Question: In one sentence, what is this figure communicating?
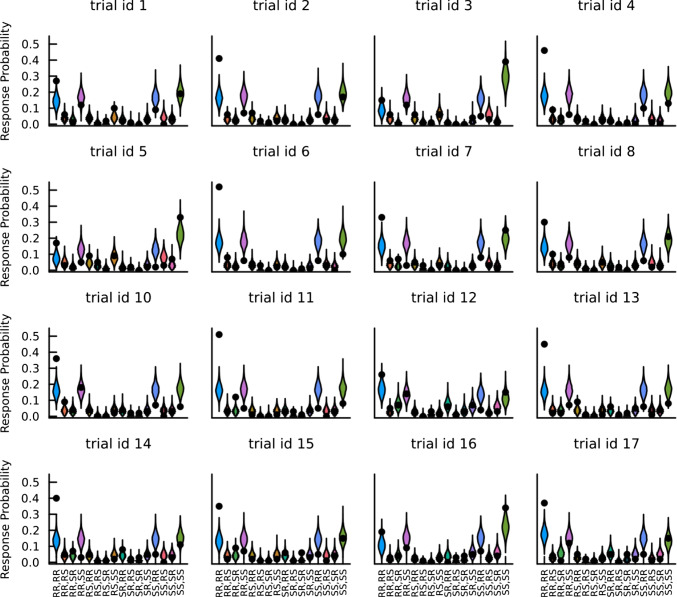
Answer: Posterior predictive distributions for \documentclass[12pt]{minimal} \usepackage{amsmath} \usepackage{wasysym} \usepackage{amsfonts} \usepackage{amssymb} \usepackage{amsbsy} \usepackage{mathrsfs} \usepackage{upgreek} \setlength{\oddsidemargin}{-69pt} \begin{document}$$\mathcal {M}_{\textrm{RPPH}}$$\end{document} for each trial. The posterior predictive response probabilities are represented as violin plots and mean empirical response probabilities are represented as black circles. Response patterns are labeled on the x-axis of the bottom row